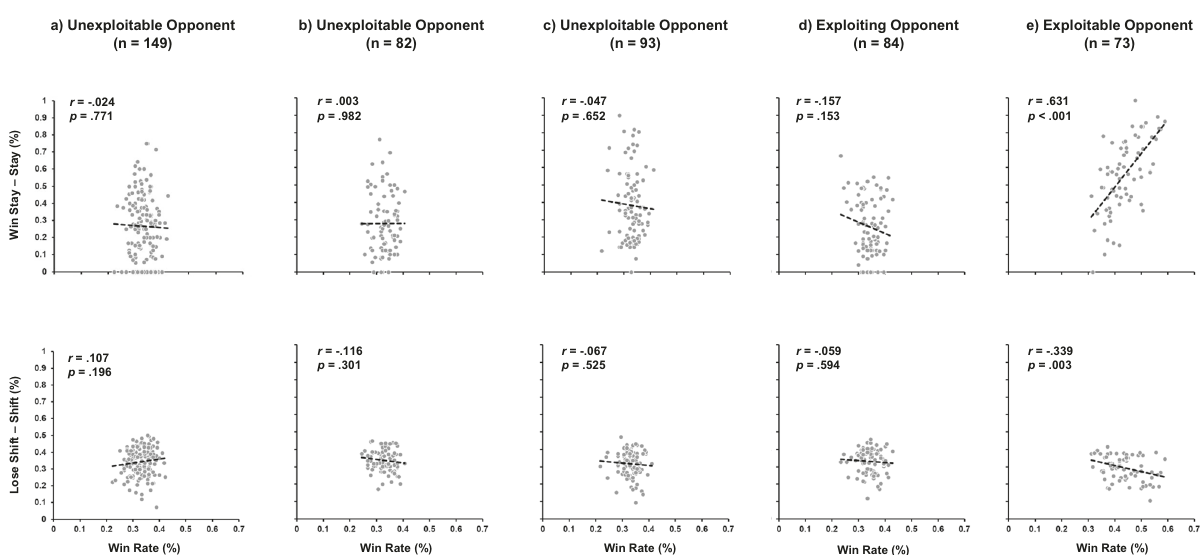
Fig. 2 Scatterplots of win-calmness ( stay – stay ) and loss-restlessness ( shift – shift ) behaviour as a function of individual win rate, and the nature of opponency. Individual performance is represented when participants engaged with A unexploitable opponents only, B unexploitable opponents in the context of exploiting opponents, C unexploitable opponents in the context of exploitable opponents, D exploiting opponents, and E exploitable opponents. Only correlations with win rate against exploitable opponents were signi fi cant win-calmness ( r = 0.631, p < 0.001), loss-restlessness ( r = − 0.339, p =